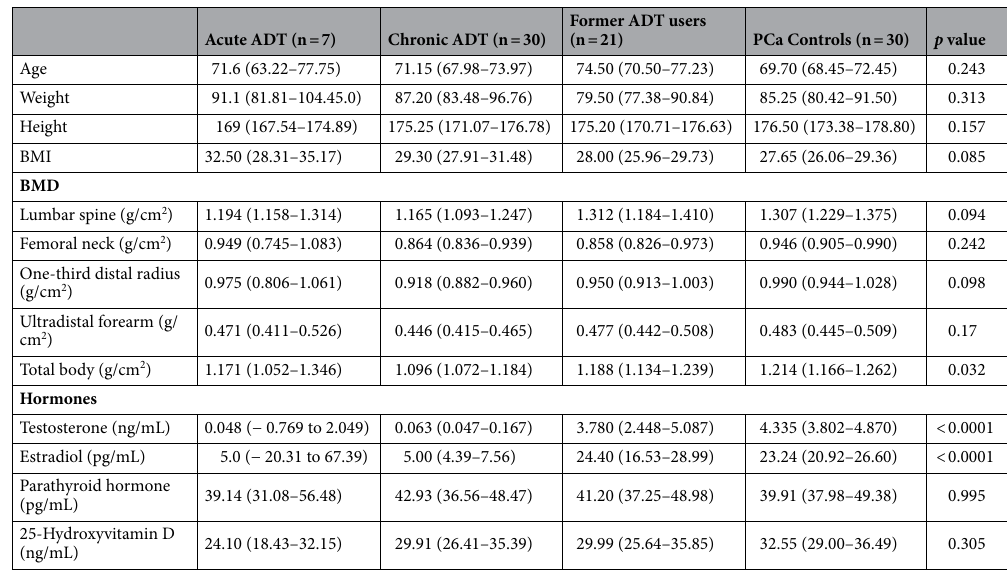
Table 1. Baseline characteristics, BMD and hormone levels. Results for continuous variables are presented as median (95% CI). Testosterone: 1 ng/mL = 3.47 nmol/L; Estradiol: 1 pg/mL = 3.671 pmol/L; Parathyroid hormone: 1 pg/mL = 0.106 pmol/L; 25-hydroxyvitamin D: 1 ng/mL = 2.496